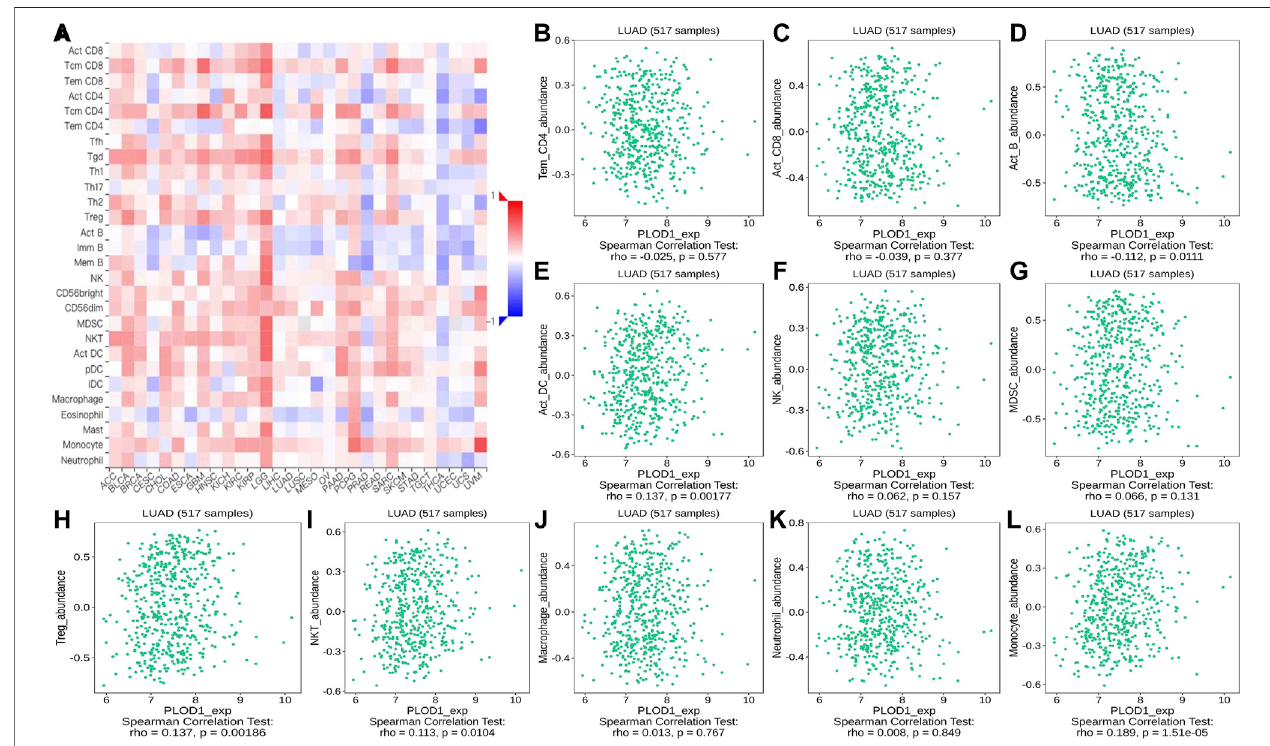
FIGURE 12 | Correlation of PLOD1 expression with TILs. (A) Heatmap of PLOD1 expression in pan-cancer from the TISIDB database. (B – L) PLOD1 expression level is signi fi cantly correlated with in fi ltrating levels of activated CD8 + T cells, activated CD4 + T cells, activated B cells, Treg cells, NKT cells, and